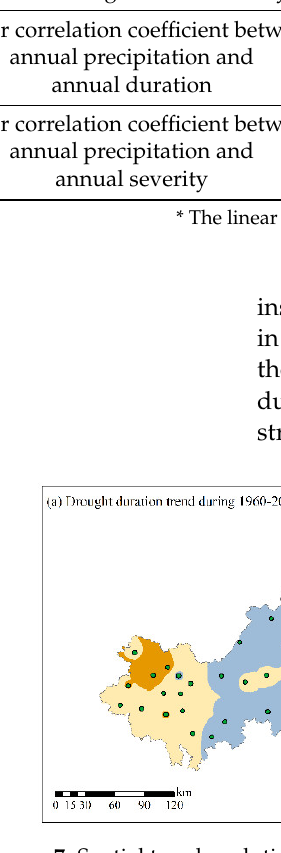
Figure 7. Spatial trend evolution of annual drought duration ( a ) and drought severity ( b ) of persistent drought events from 1960 to 2015.